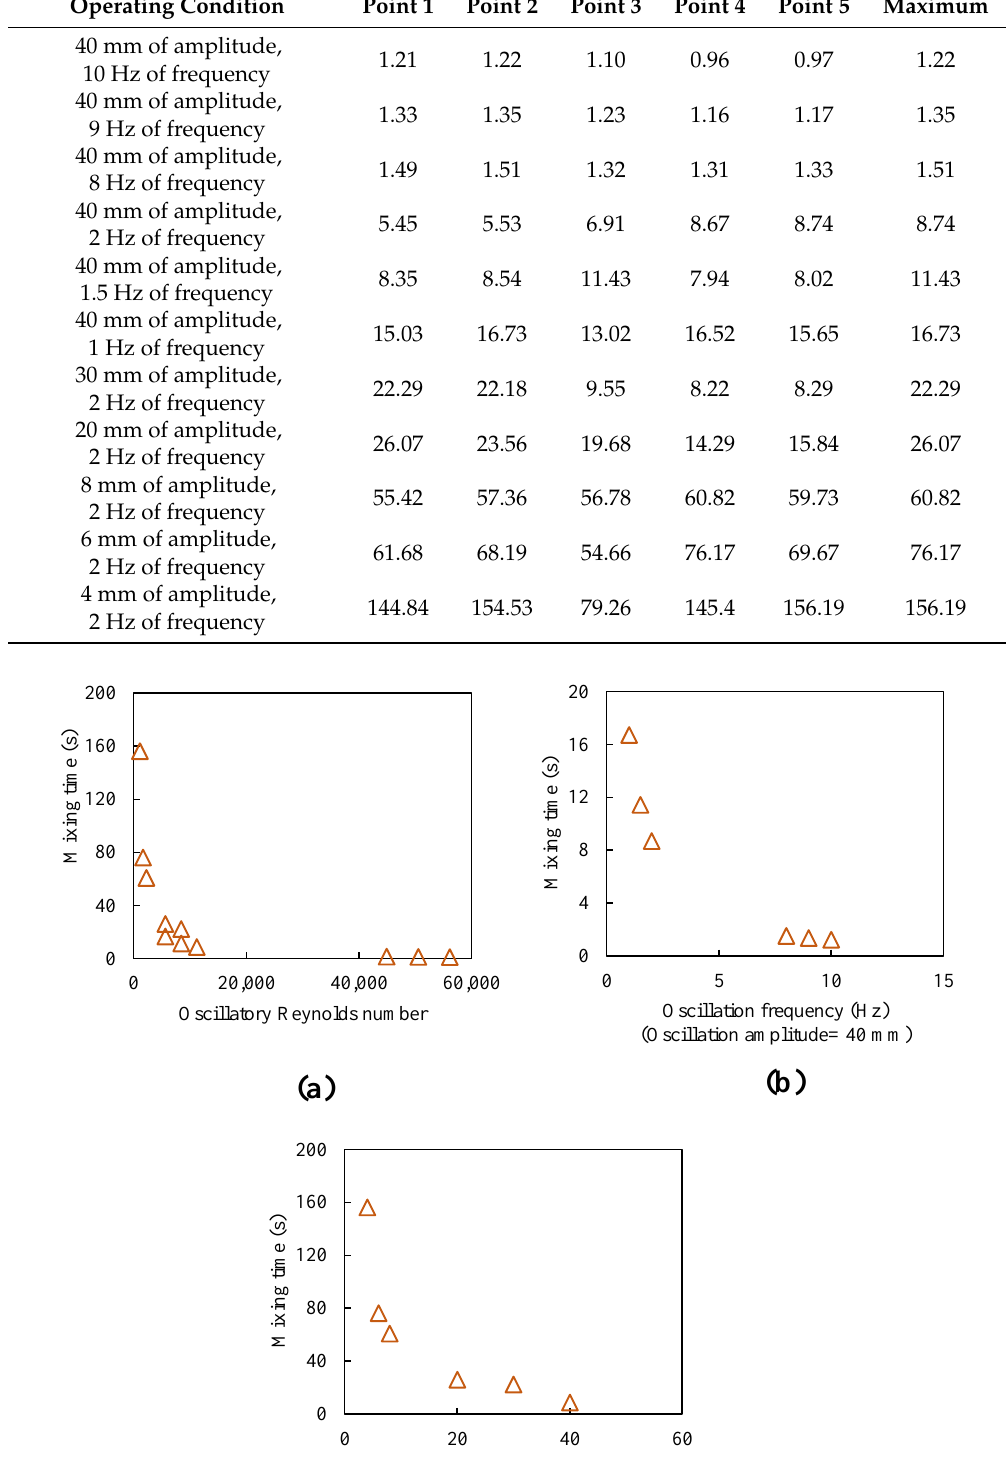
Oscillation amplitude (mm) (Oscillation frequency= 2 Hz) (c)